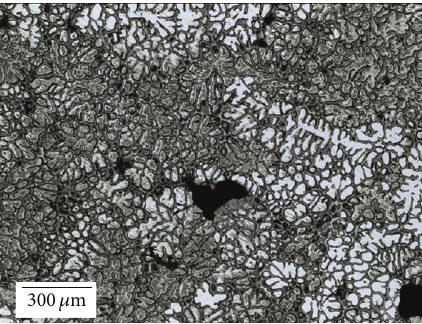
Figure 2: Optical microscopy image of Al-25 at.% Zn alloy. The sample was quenched in liquid nitrogen, polished, and etched for 5 s with 10wt.% NaOH solution.